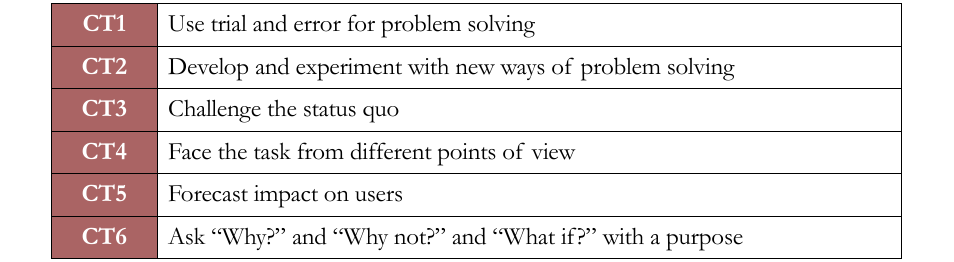
Table 3. Behavioral indicators in the FINCODA Critical Thinking dimension